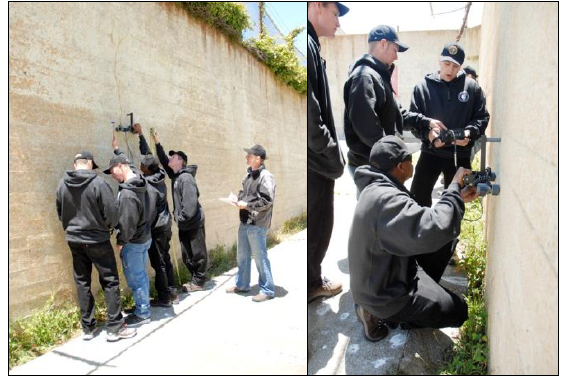
Figure 4. Chico State Students with Olson Instrument Engineer taking SASW measurements across a crack in the wall of the Rec